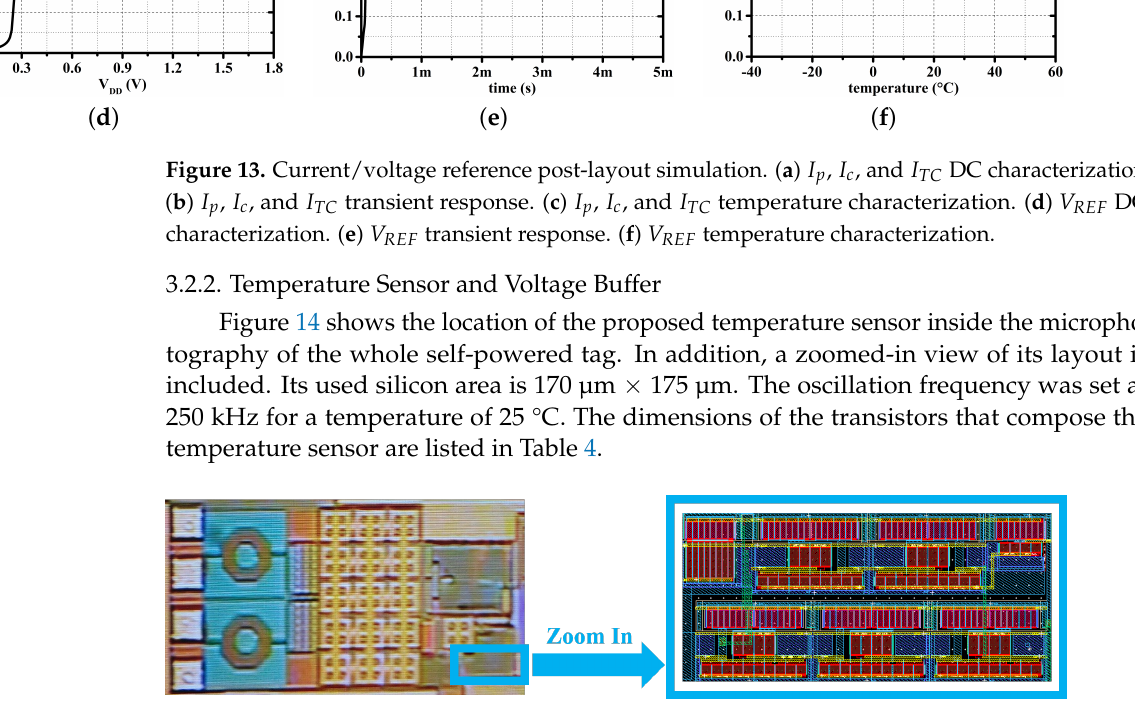
Figure 14. Location of the proposed temperature sensor inside the microphotography of the whole self-powered tag and a zoomed-in view of its layout. Table 4. Elements and transistor sizes of the temperature